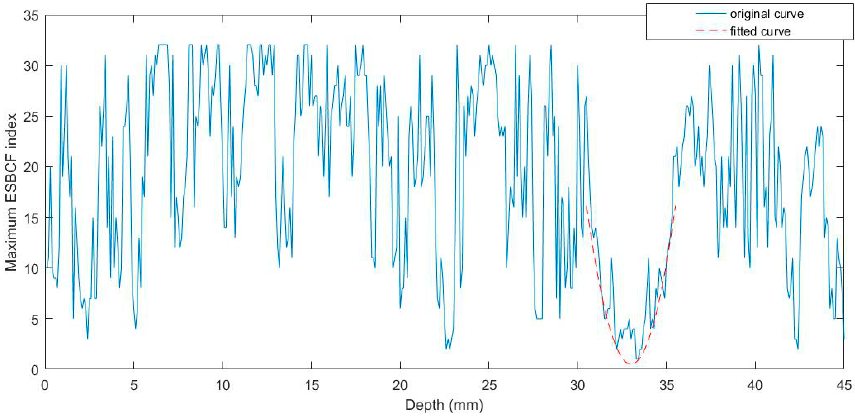
Figure 6. The fitted maximum ESBCF index curve.